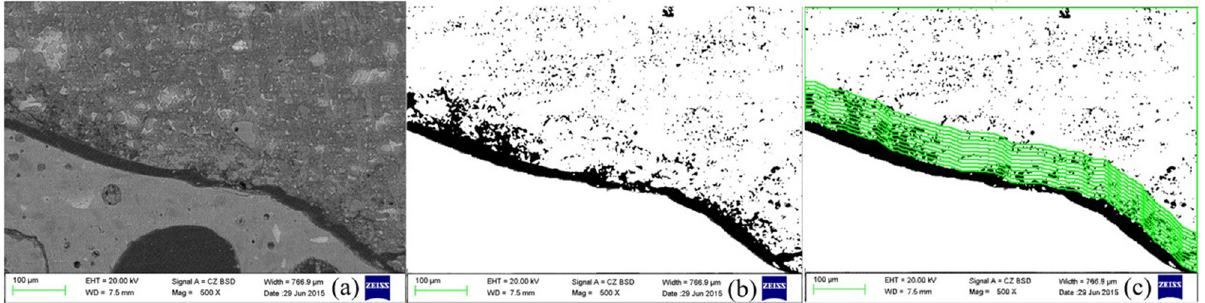
Figure 4: Example of the BSE – SEM image analysis procedure: ( a ) the BSE - SEM image, ( b ) pore segmentation, and ( c ) strip delineation [ 39 ]